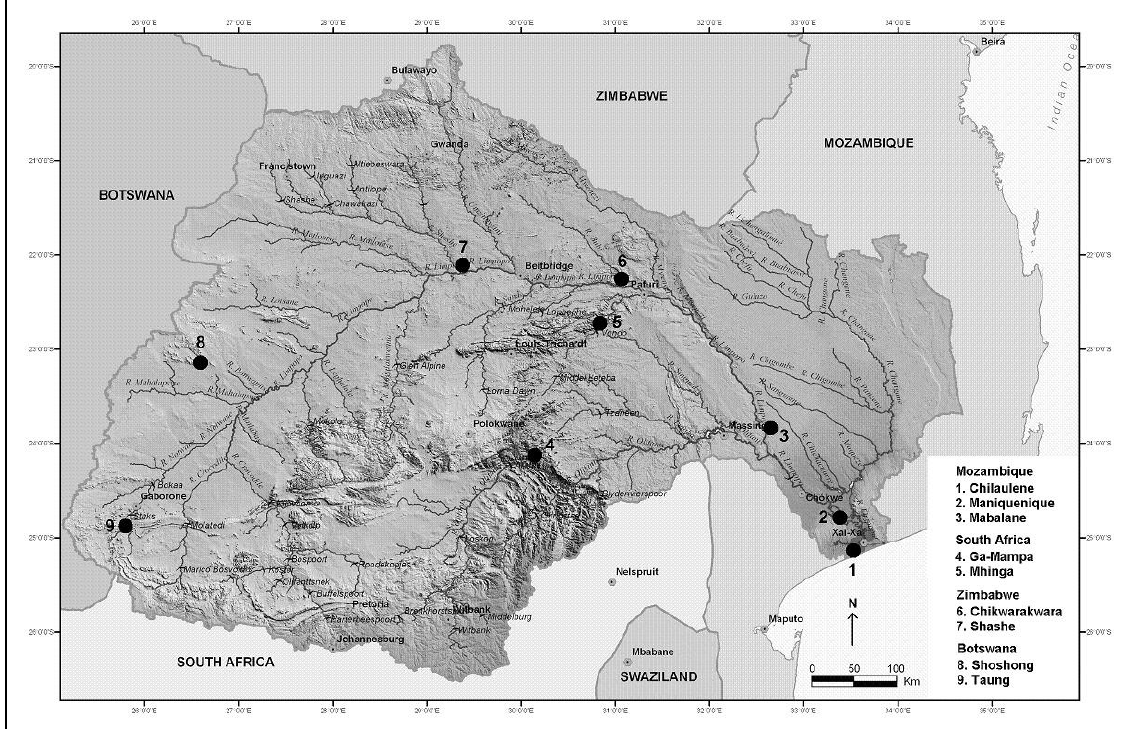
Figure 2. Relief characteristics of the Limpopo River basin and location of the nine project study